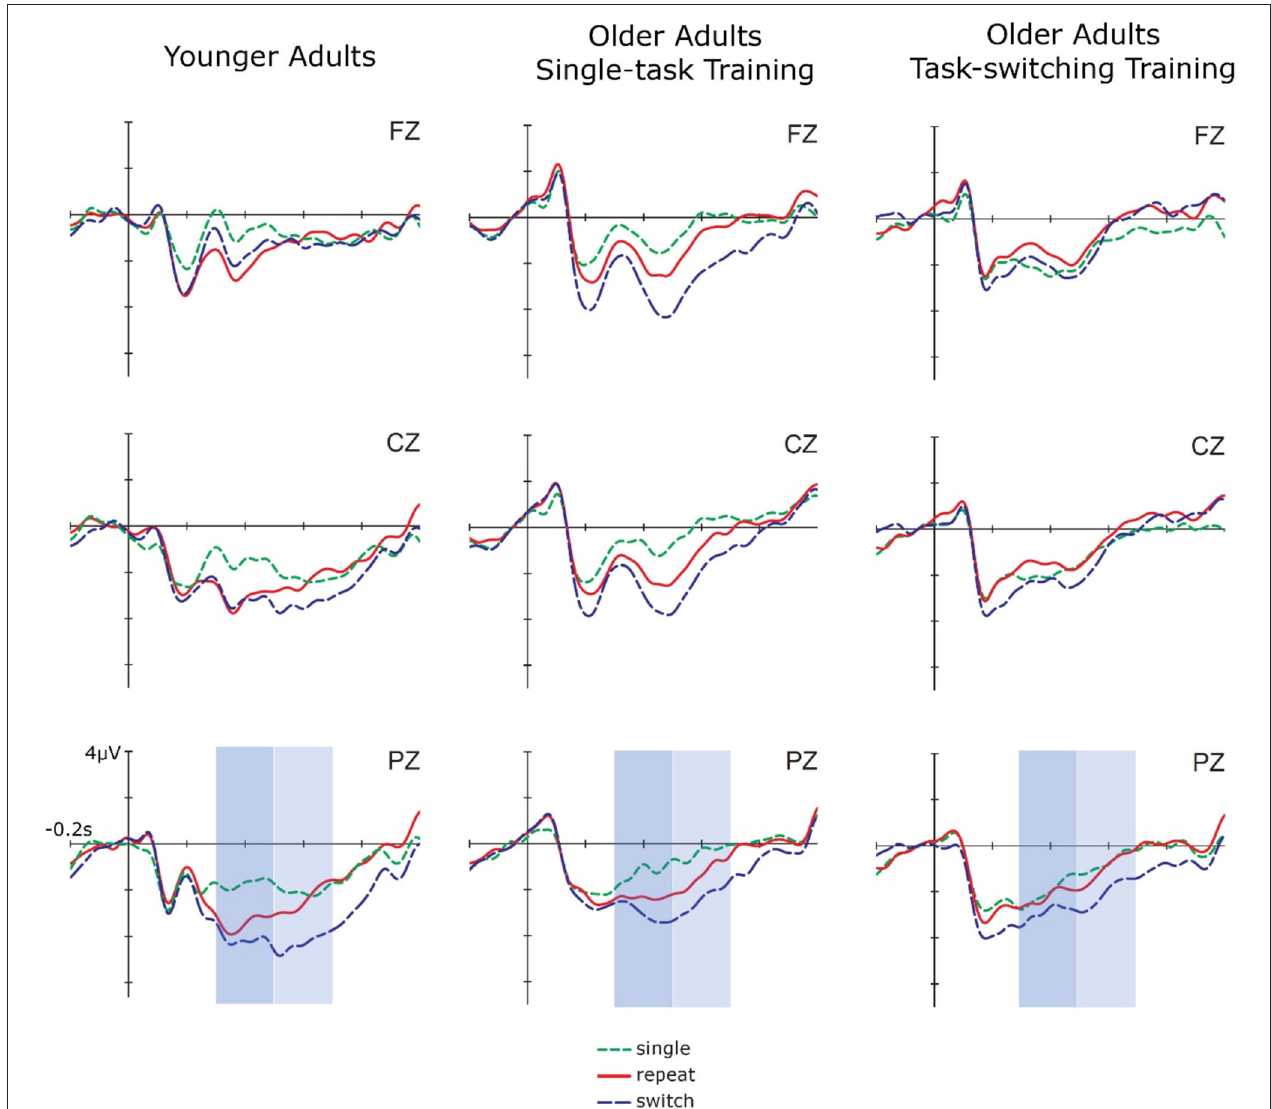
FIGURE 4 | Cue-locked ERPs in single, repeat, and switch trials at posttest for younger adults, older adults in the single task training group, and older adults in the task-switching training group displayed at electrodes Fz, Cz, and